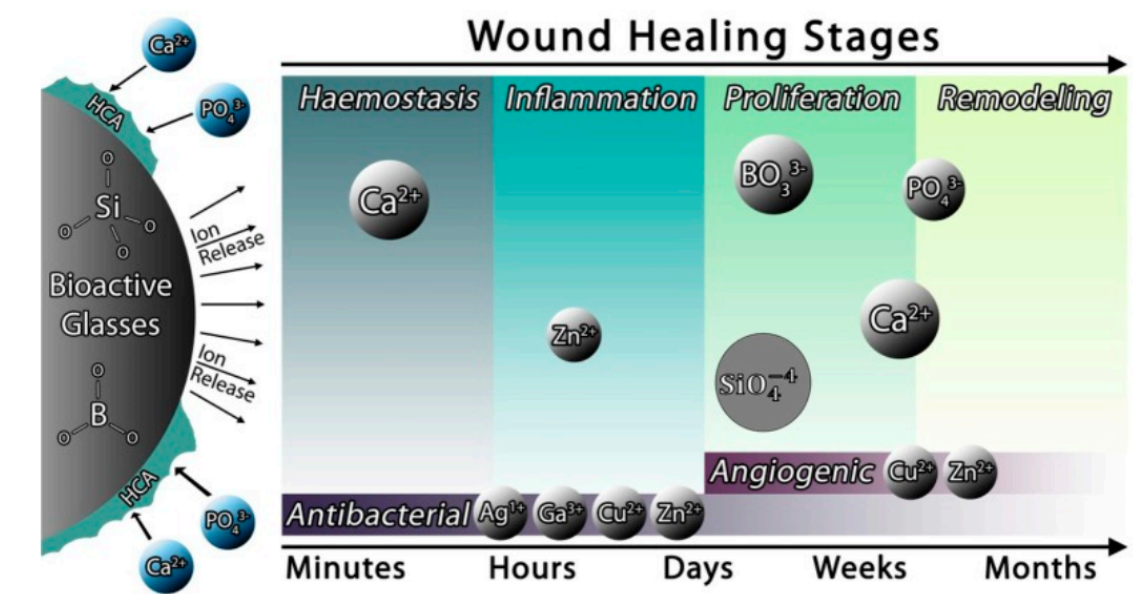
Figure 6. The release of some metal ions from BGs into the surrounding environment has a positive effect on wound healing